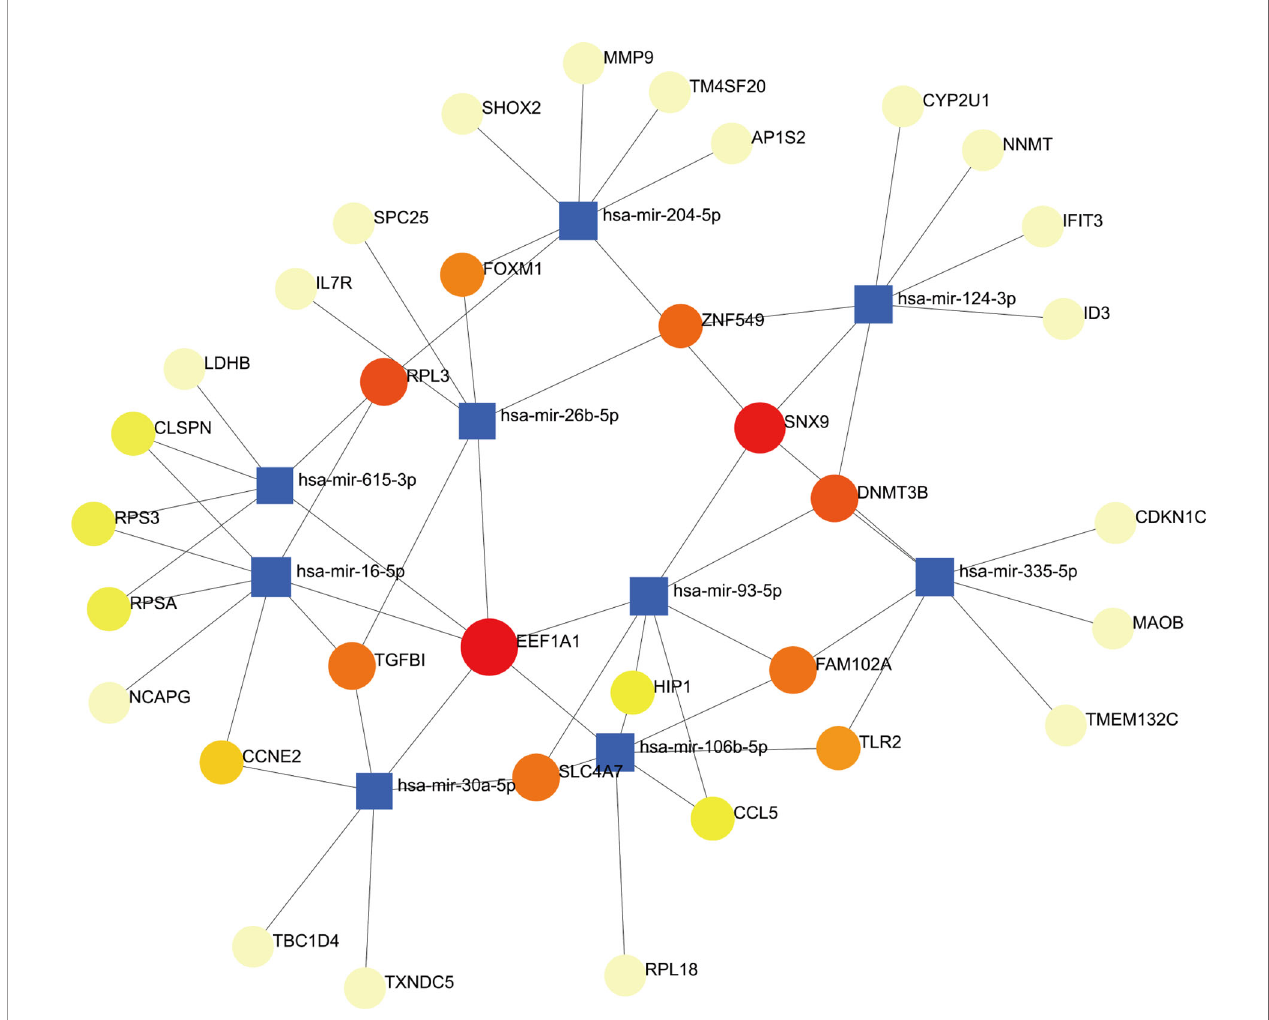
FIGURE 8 | The interconnected regulatory interaction network of DEGs-miRNAs. The circle node indicates miRNAs and the gene symbols interact with miRNAs in the shape of a